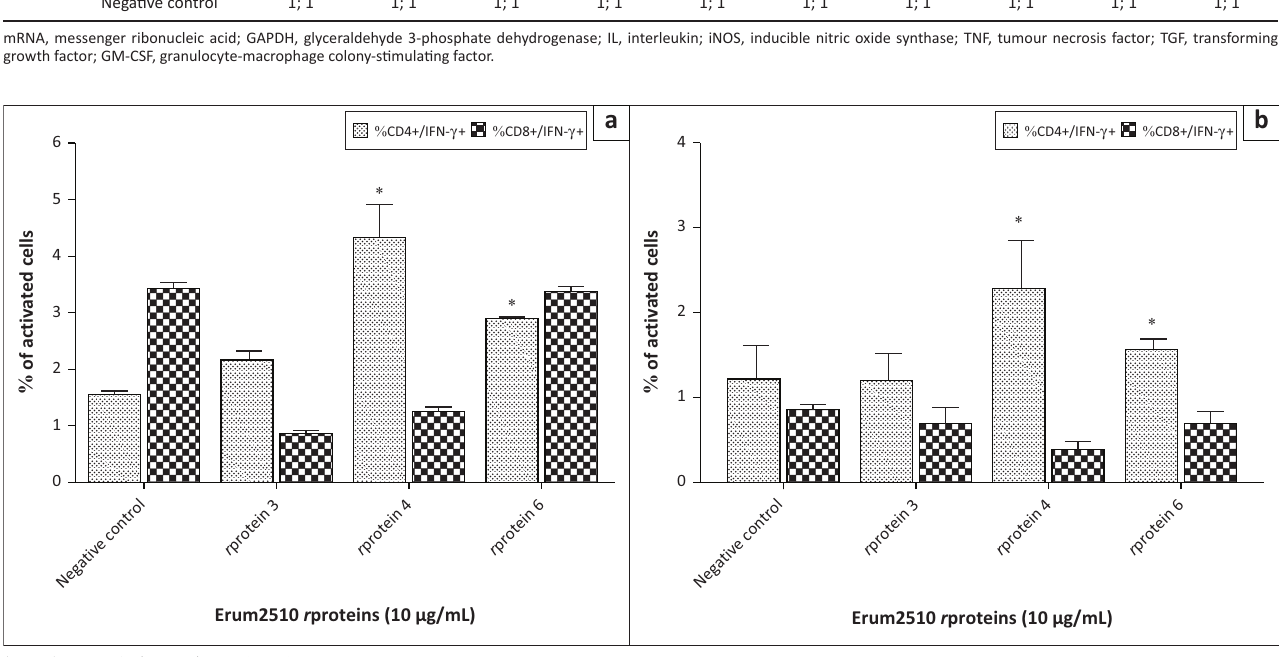
FIGURE 2: Average percentage of peripheral blood mononuclear cells (PBMC) from s6823 (a) and sM2 (b) that stained positive for CD4 and interferon gamma (IFN- γ ) and CD8 and IFN- γ expression markers after stimulation with Erum2510 r proteins 3, 4 and 6. Unstimulated PBMC was included as negative control. Peripheral blood mononuclear cells were stimulated with 10 µg/mL r protein and incubated for 72 h, after which the percentage of cells was determined by flow